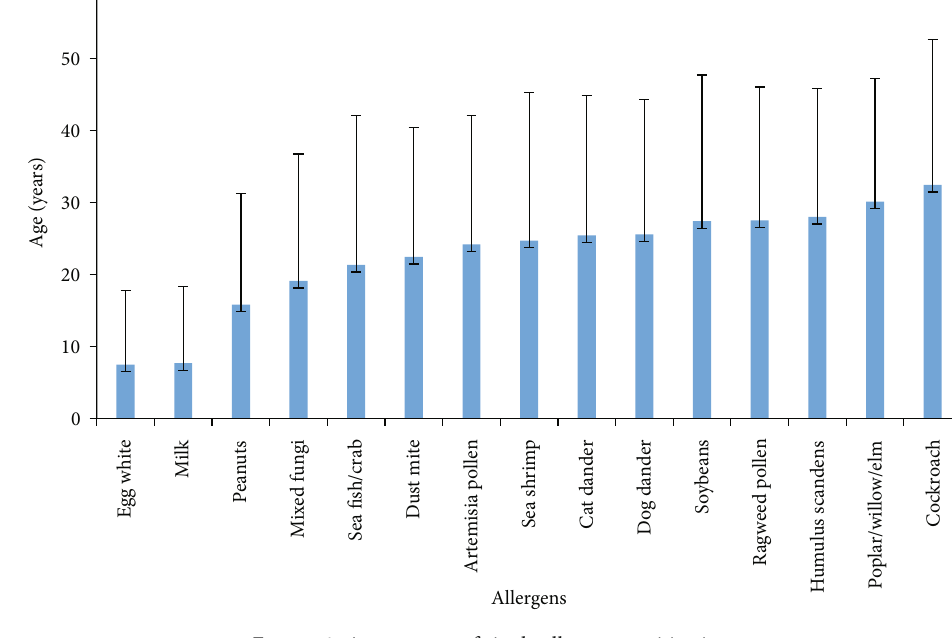
Figure 2: Average age of single allergen sensitization.